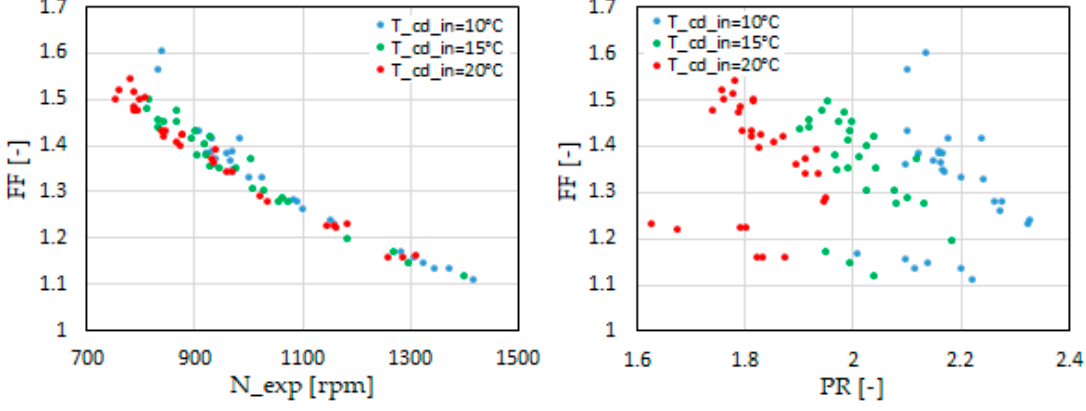
Figure 8. Scroll expander filling factor with shaft speed ( left ), and with pressure ratio (PR) ( right ).